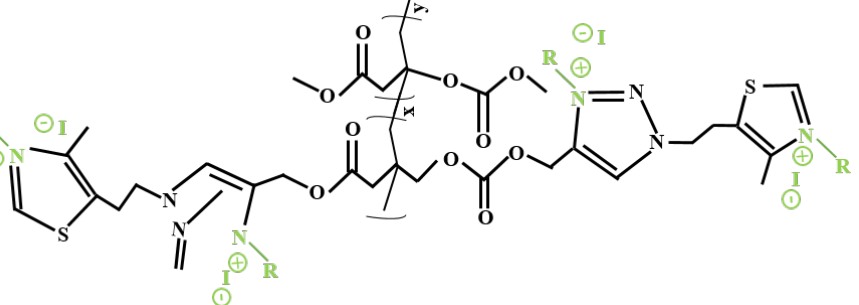
Figure 8. IA derivate cationic antimicrobial copolymer (adapted after [145]).